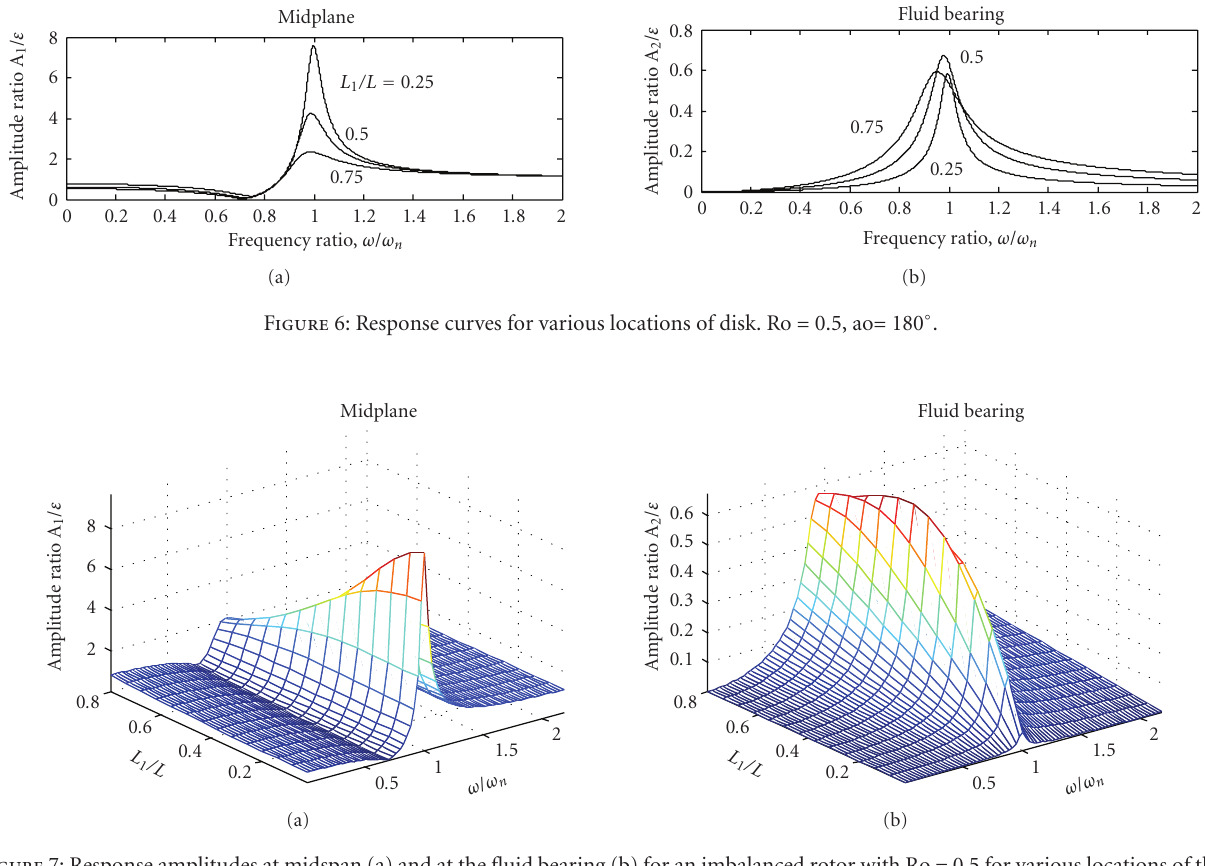
Figure 7: Response amplitudes at midspan (a) and at the fluid bearing (b) for an imbalanced rotor with Ro = 0.5 for various locations of the midspan